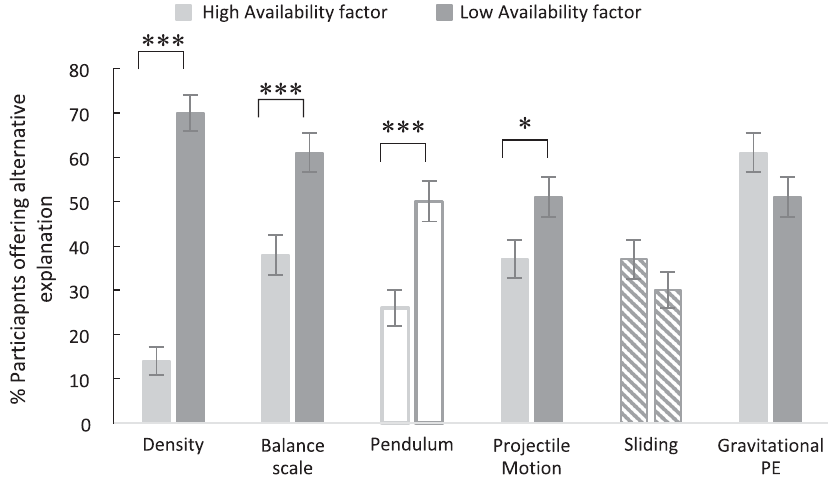
FIG. 4. Experiment 3 results for the multiple-choice format. Hashed bars indicate the scenario in which no significant difference between the accessibilities of the explanations was determined. Outlined bars are used for the pendulum scenario, in which the standard measure of differences between accessibilities showed no significance, but other measures